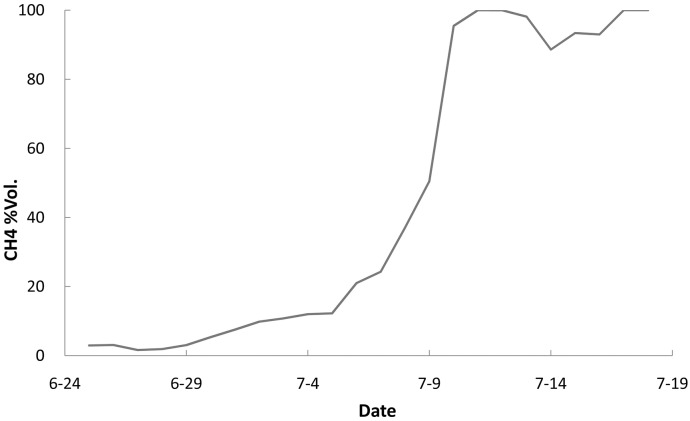
Methane concentration changes for a methanogenic consortia cultured with nutrition solution #2 at 39°C and pH 8.21.The contents of the solution were (in g/L) NaHCO3, 0.20; NH4Cl, 1.00; NaH2PO4, 1.30; KCl, 0.50; MgSO4•7H2O, 0.20; CaCl2•5H2O, 0.10; C17H35COONa, 1.30; R1SO2OR2, 0.80; yeast extract, 0.50; resazurin, 0.10.